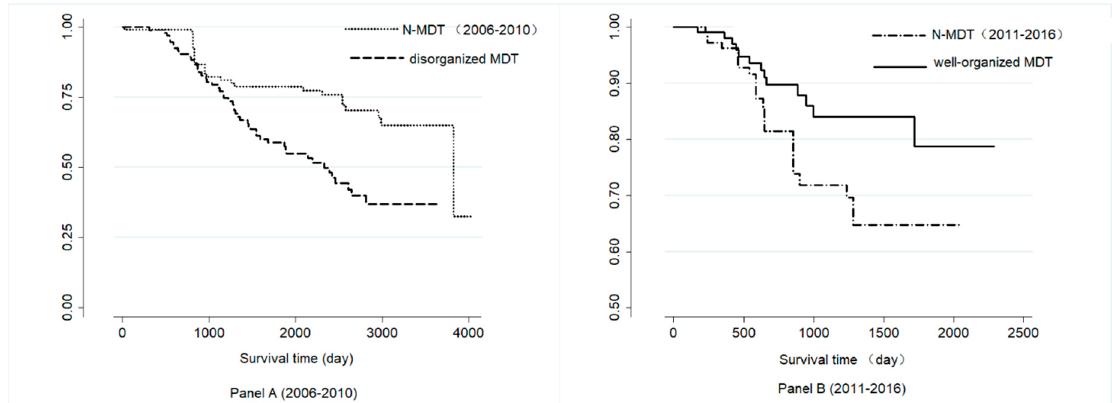
Figure 3. Survival curves of the different groups in Panel A and Panel B. MDT: Multidisciplinary teams, N-MDT: without multidisciplinary teams’ treatment; Panel A: patients who were treated